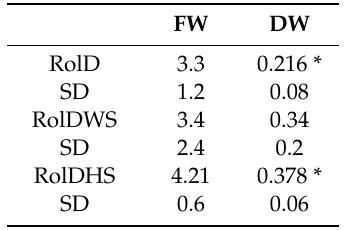
Table 1. Mean fresh weight (FW), mean dry weight (DW), and standard deviations (SD) of RolD: non-stressed transgenic plants; RolDWS: transgenic plants exposed to water stress; and RolDHS: transgenic plants exposed to heat stress samples (g).